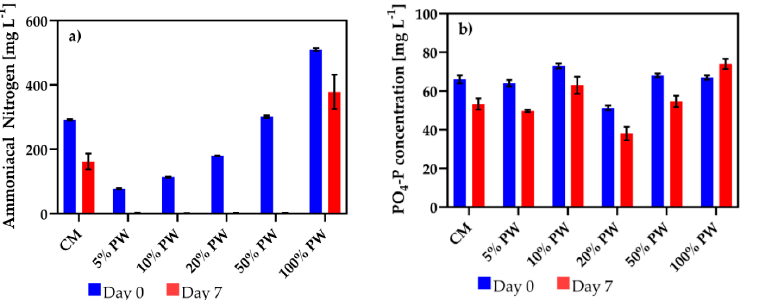
Figure 2. ( a ) NH 4 –N removal and ( b ) PO 4 –P removal; by G. sulphuraria in CM and different PW dilution experiments over 7 days Data points represent the average ± SD of n = 3 biological replicates. The removal of NH 4 –N, NO 3 –N and PO 4 –P by C. vulgaris in BBM and different PW dilution experiments over 7 days are presented, respectively, in Figure 3a, 3b and 3c.